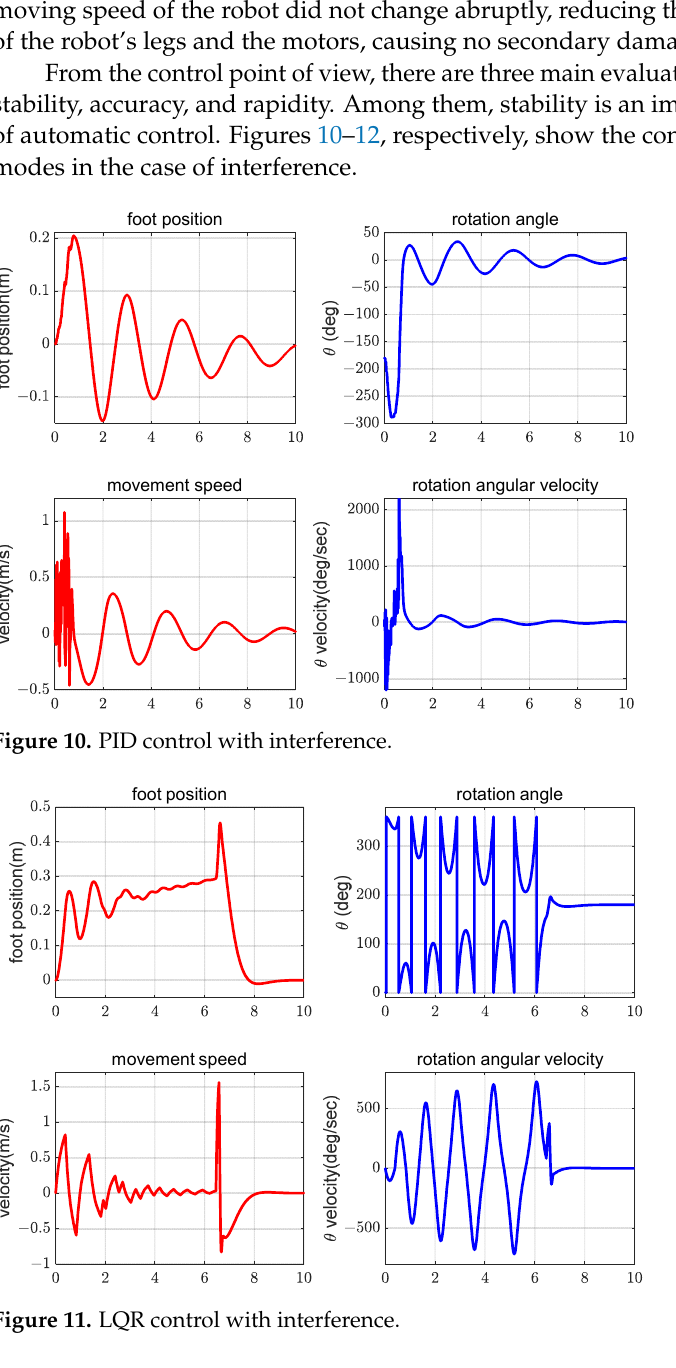
Figure 12. DDPG control with interference. From the comparison of Figure 7 to Figure 12, it can be seen that after the interference was introduced, the recovery process of the LQR ‐ controlled robot was the same as that without interference, while PID and DDPG made use of the interference to speed up the recovery process. The key indicators of three algorithms in the self ‐ recovery process are shown in Table 2. Table 2. The key indicators of three algorithms in the self ‐ recovery process. Performance Index